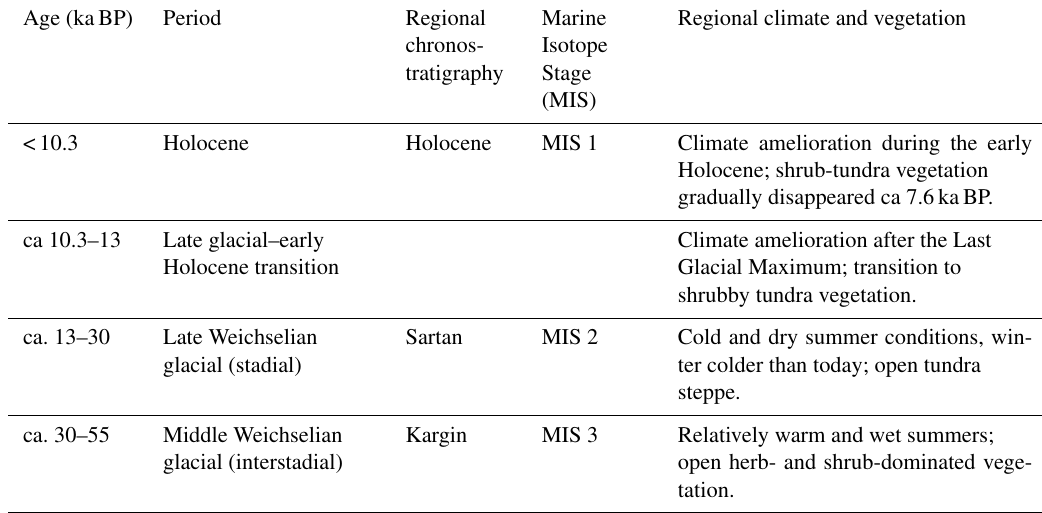
Table 1. Compilation of the regional chronostratigraphy of the Laptev Sea region used in this work with paleoclimate (summer) and vegeta- tion history based on an overview by Andreev et al. (2011) and references therein.